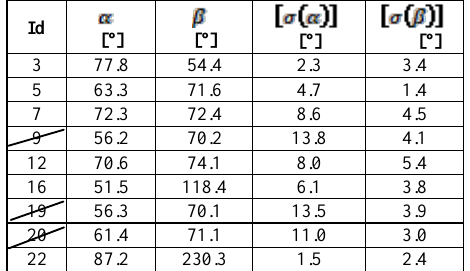
Table 2. Example of dip and dip-direction values and their associated standard deviations